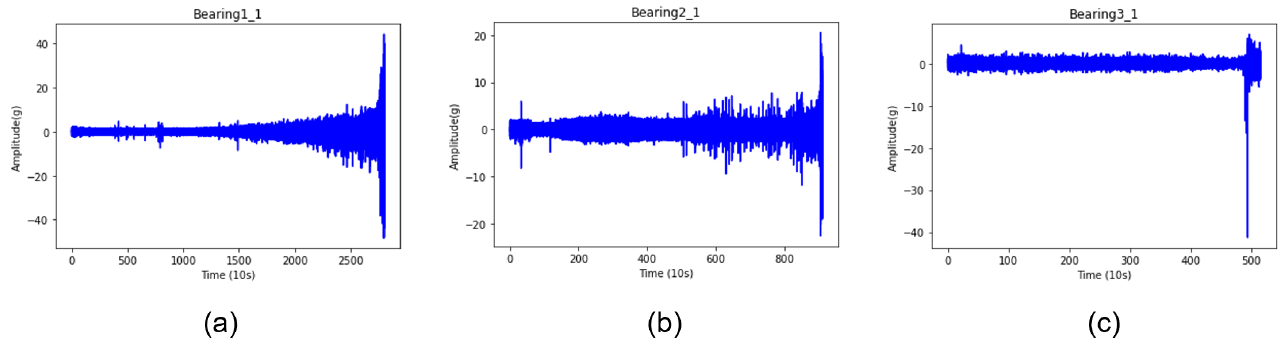
Figure 9. Measured vibration profile of test bearings: ( a ) Test Bearing1_1, ( b ) Test Bearing2_1, ( c ) Test